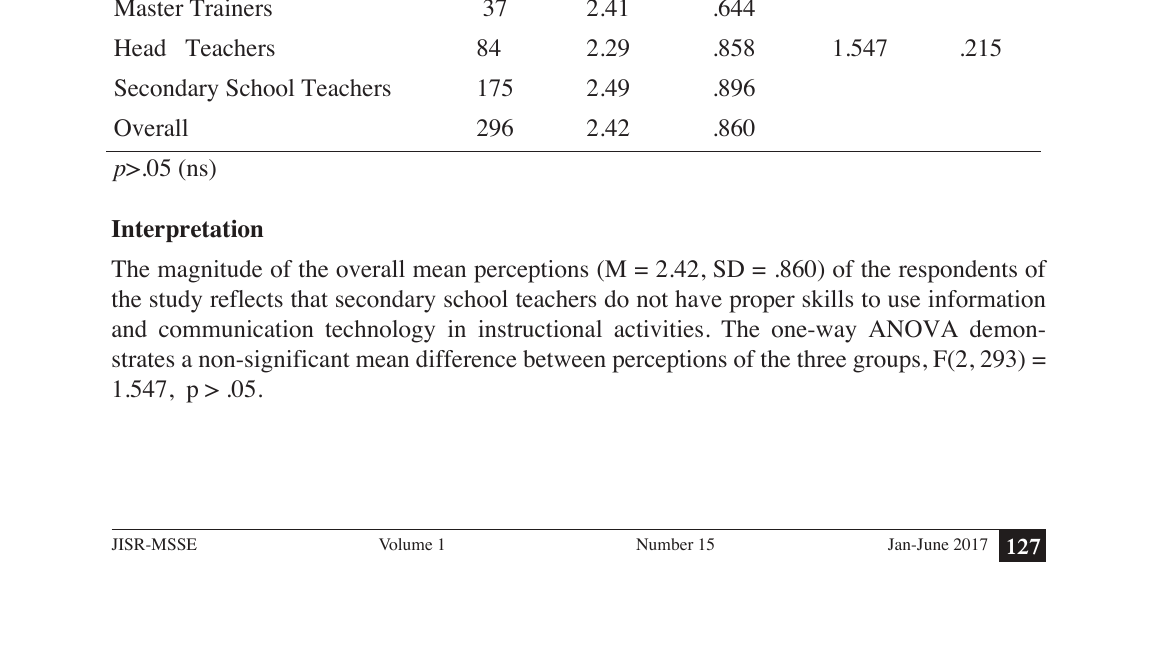
Table.6 Teachers have proper skills to use information and communication technology